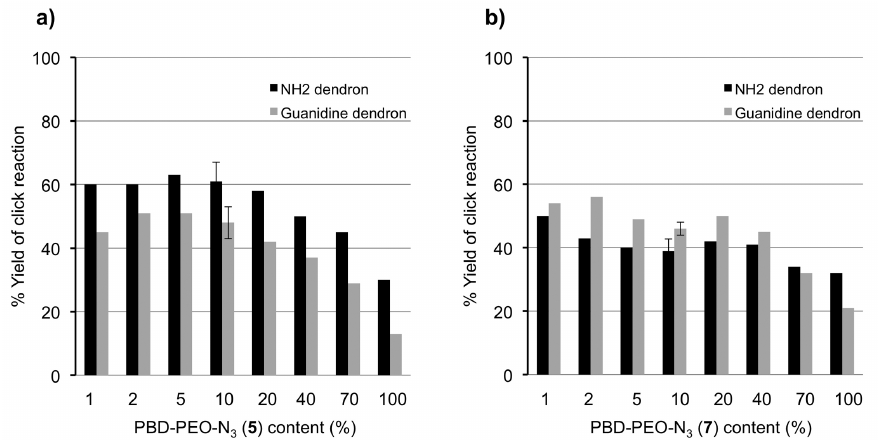
FIGURE 11 - Yields for the “click” conjugation between the rhodamine-labelled versions of dendrons 2 or 3 and PCL-PEO a) vesicles, and b) micelles as a function of PCL-PEO-N content (remainder is 3